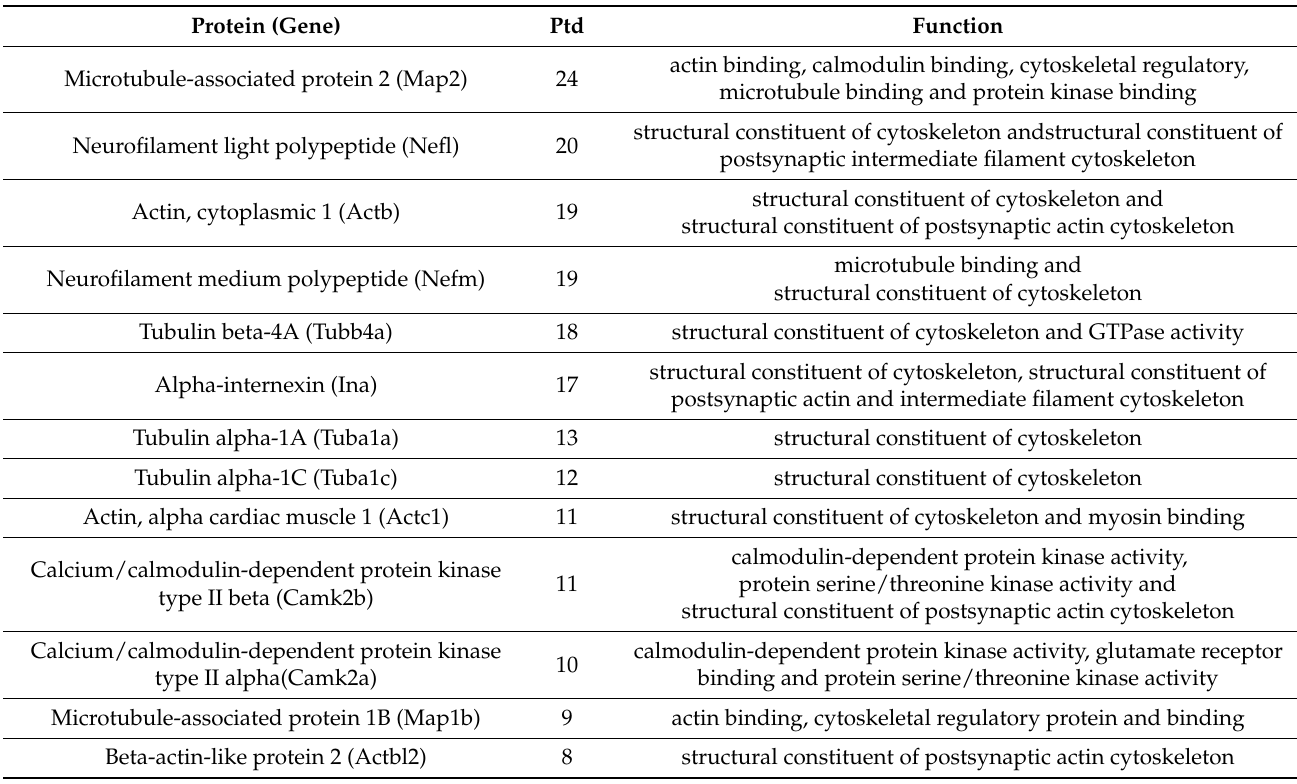
Figure 2. The interactome of NCAM2; the mass spectrometry approach. ( A ) Schematic representation of the mass spectrometry approach. Brain lysates from P10–12 mice were enriched in membrane proteins and incubated with magnetic beads, which were previously conjugated with an antibody against NCAM2.1 or against both NCAM2 isoforms. The eluted proteins were processed for mass spectrometry analysis. A list of 103 proteins that interact with NCAM2 was obtained with a False Discovery Rate ≤ 0.01%, Table 1. ( B ) WB detection of NCAM2.1 and NCAM2 proteins in the cytosolic, membrane and insoluble fractions of the brain lysates used for the mass spectrometry assay. NCAM2.1 isoform is detected in both fractions, the membrane and the insoluble fraction while NCAM2.2 is specially enriched in the insoluble fraction. Tubulin was used as a loading control. ( C ) WB detection of NCAM2 from samples of magnetic beads elution. Table 1. The interactome of